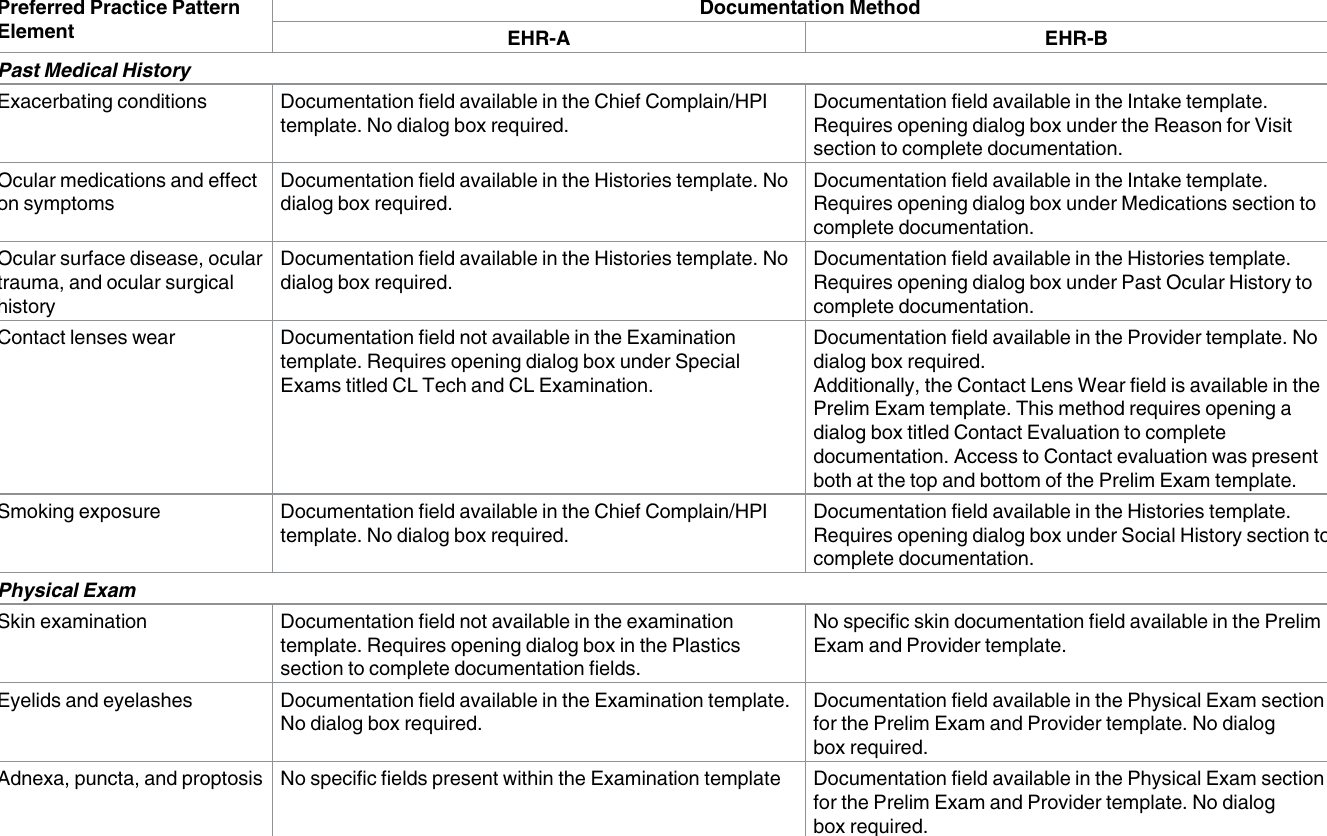
Table 1. Differencesin documentation methods of different chart note template